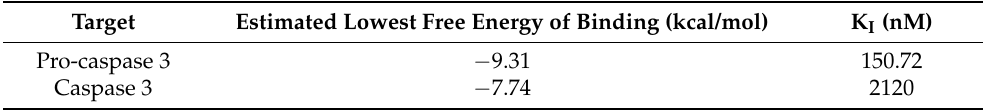
Table 6. Predicted lowest free energy of binding expressed in kcal/mol and inhibition constant (K I ) expressed in nanomolar (nM) for pro-caspase 3 and caspase